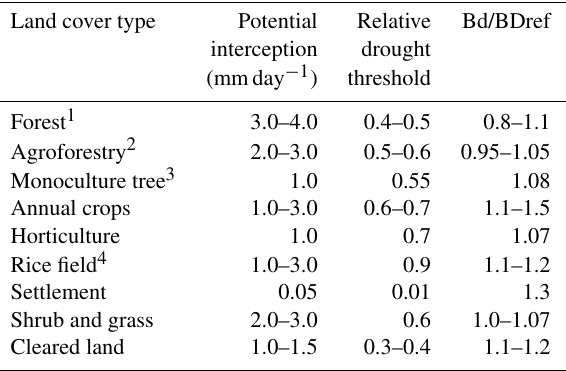
Table 3. GenRiver defaults for land-use-specific parameter values, used for all four watersheds (BD/BDref indicates the bulk density relative to that for an agricultural soil pedotransfer function; see van Noordwijk et al.,